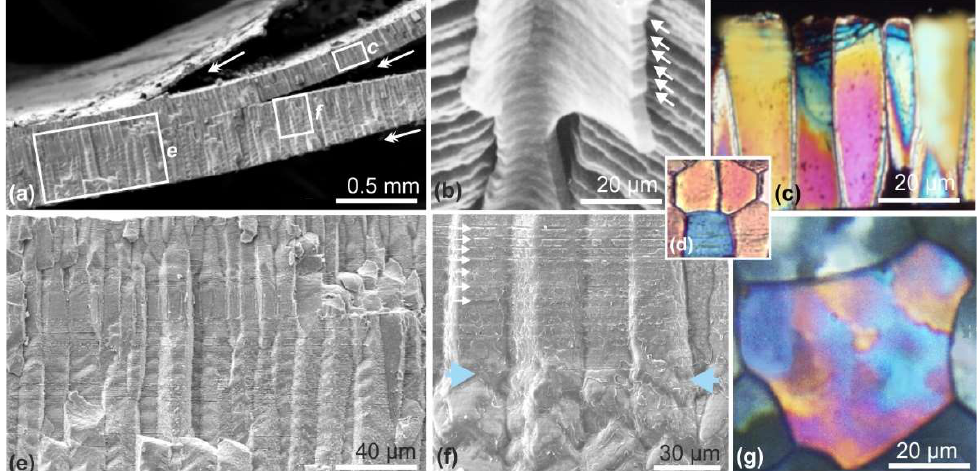
Figure 7. Shift from single-crystal-like units to polycrystalline organization of the calcite prisms in Pinctada margaritifera. ( a ) The shell stepping growth at the macro-scale; three scales of various thicknesses due to three mantle withdraws. ( b ) The stepping growth at the microscale seen by the synchronic growth of the envelopes and the mineral phase of the prisms. ( c , d ) Overall similarity in crystallographic orientation during early elongation of the prisms (about 200 µm). ( e , f ) The surface fracture of the shell reveals the morphological changes in prisms. ( g ) Diversity of crystal orientations in the second growth phase of the prisms.